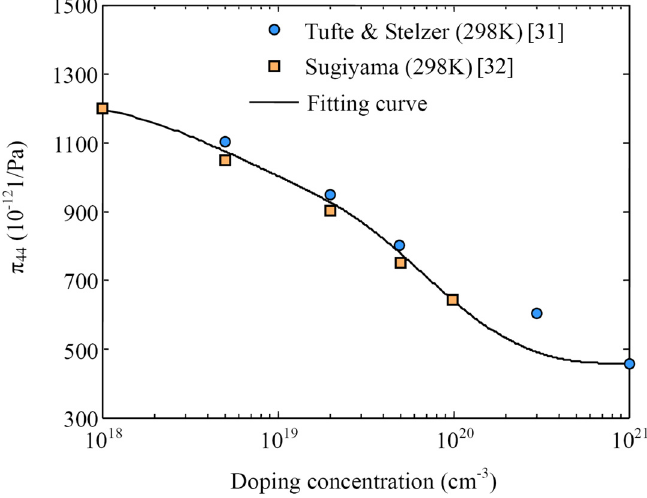
Figure 11. Dependences of longitudinal PRCs π